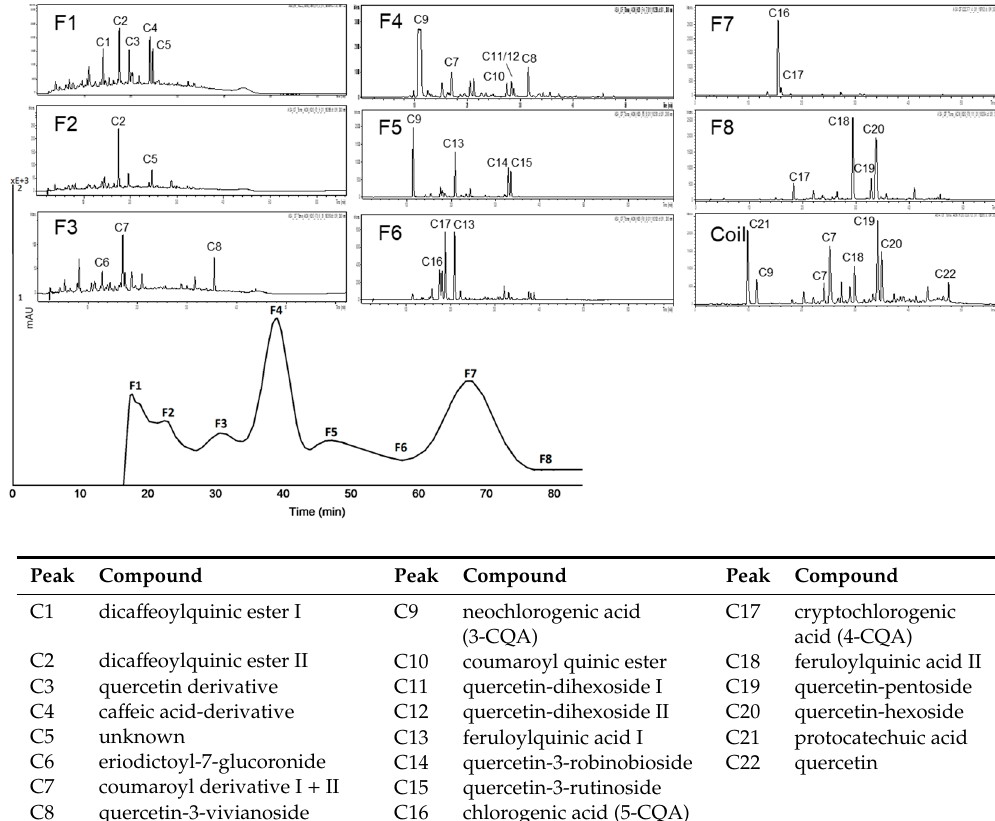
Figure 8. HPCCC chromatogram at a wavelength of λ 320 nm of A-CF and HPLC-ESI-MS / MS chromatograms of the composition of each fraction.